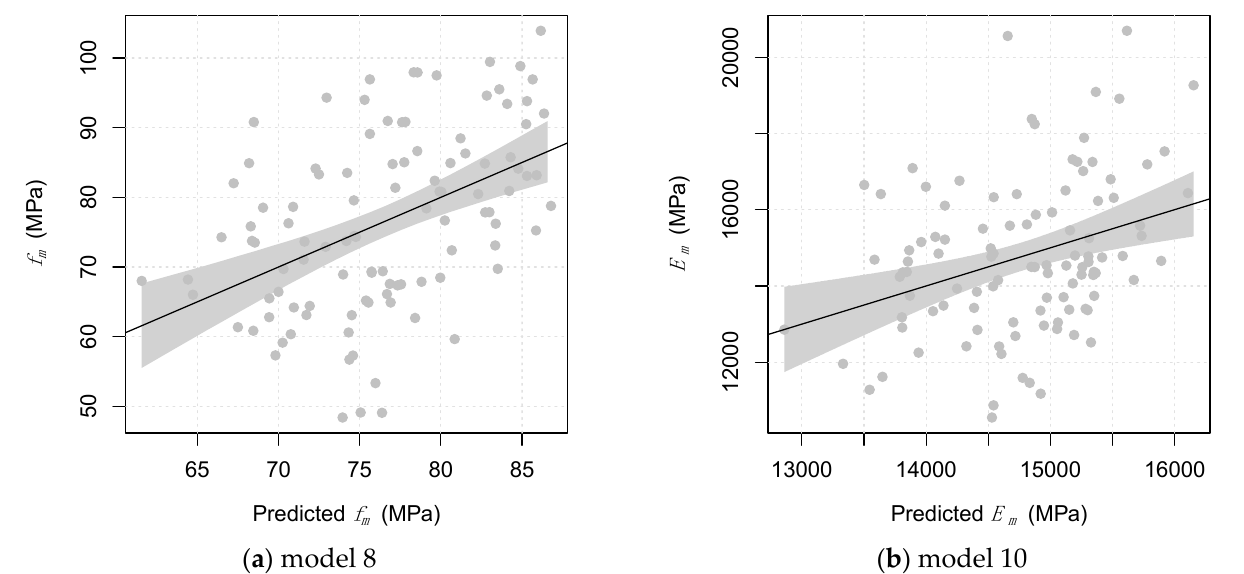
Figure 2. Observed vs. predicted values: ( a ) model 8 of Table 6 as the best model for the prediction of bending strength ( f m ); ( b ) model 10 of Table 6 as the best model for the prediction of static modulus of elasticity ( E m ). The grey shaded area represents the 95% confidence interval.